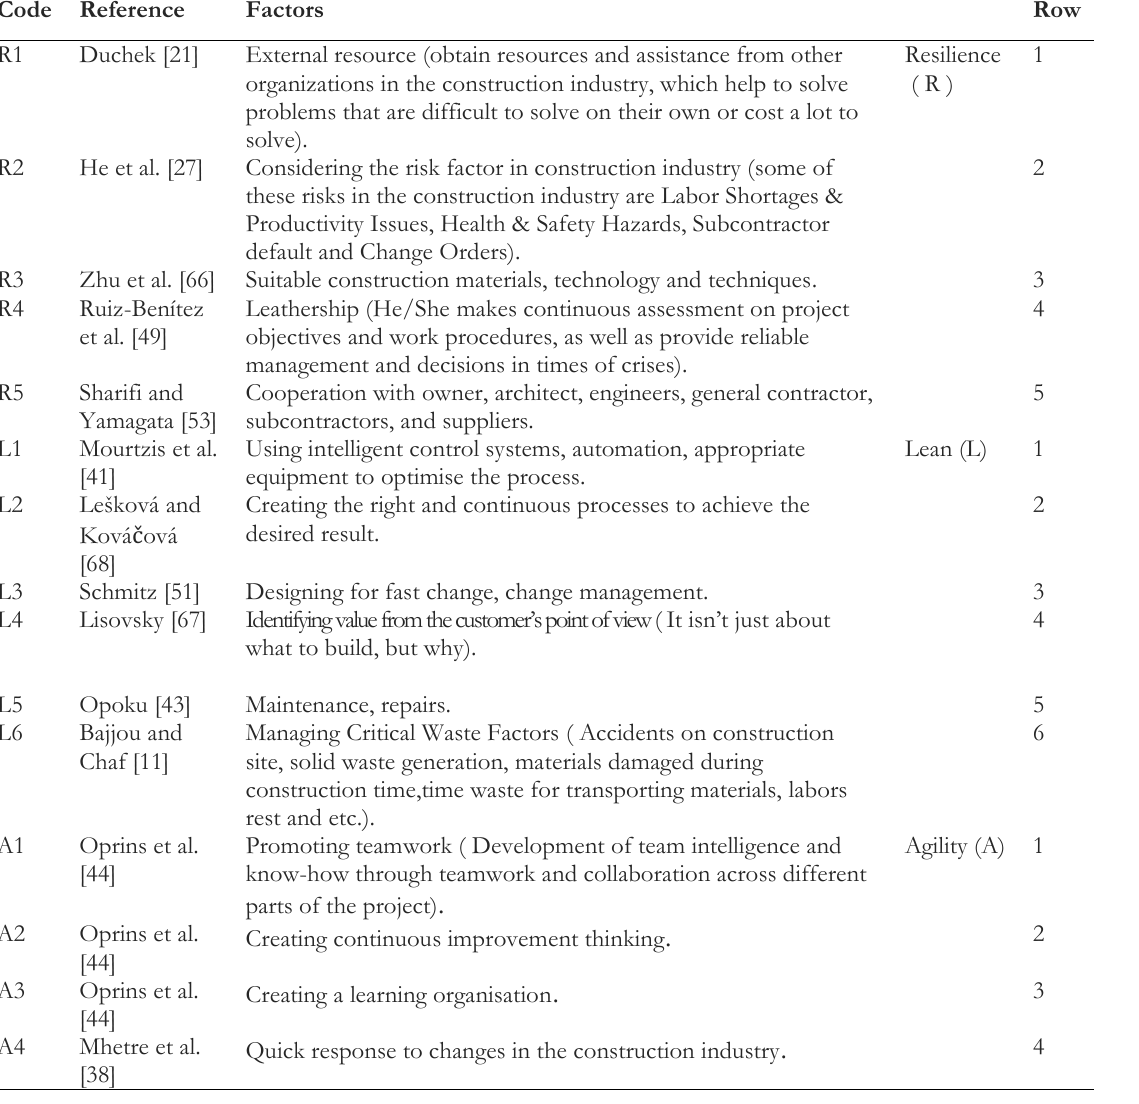
Table 5. Localized factors of GPM from lean, agile and resilient dimensions in the construction industry.